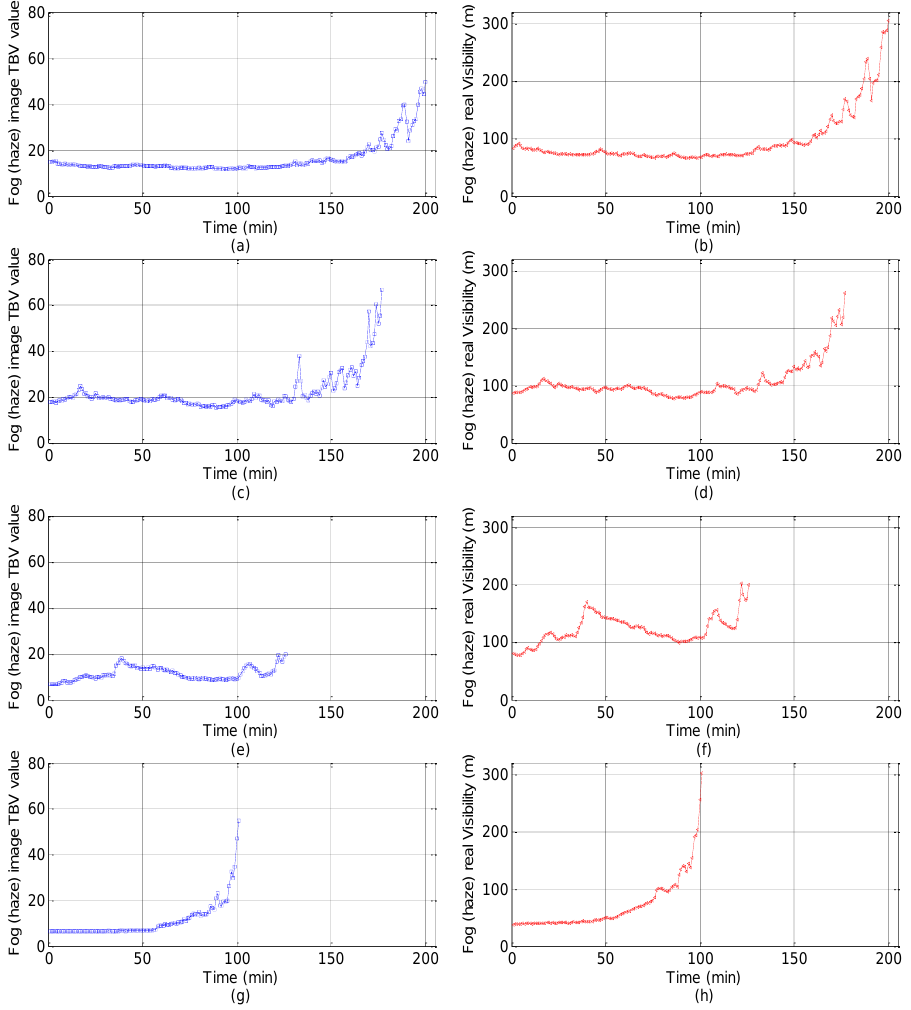
Figure 6. Varying trend comparison between the TBV ratio and the real visibility. (The data shown in ( a , c , e , g ) denote the TBV ratio values of Points 2, 4, 5, and 6, respectively. The data shown in ( b , d , f , h ) indicate the foggy and hazy visibility values of the Points 2, 4, 5, and 6, respectively.)